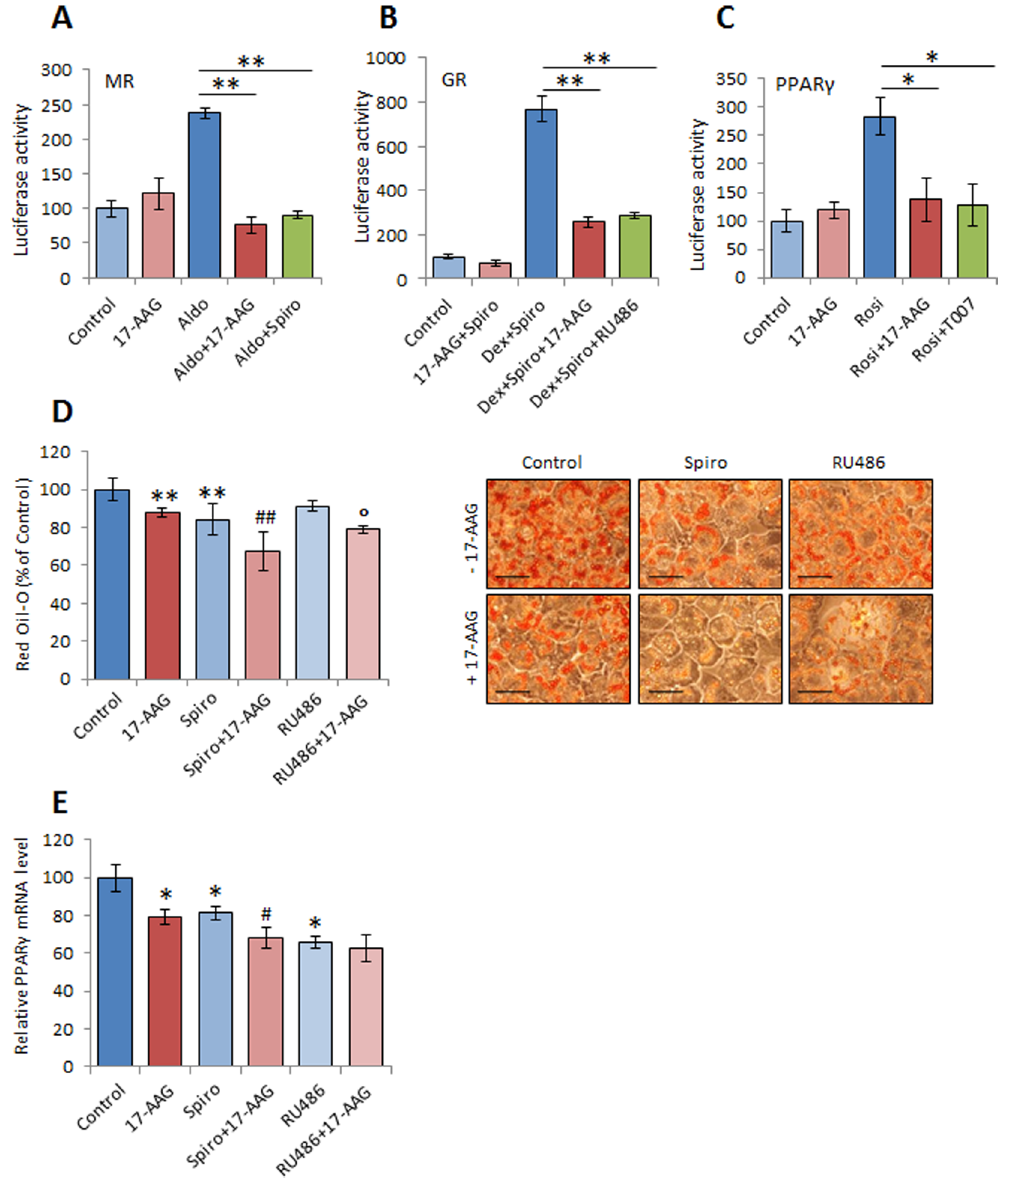
Figure 5. Hsp90 blockers inhibitMR, GR and PPAR c transcriptional activity in adipocytes. (A to C) Mature 3T3-L1 cells were co-transfected by Metafectene with the reporter genes MMTV-luc (for A and B), PRE-luc (for C), and the constitutive luciferase vector coding for Renilla. After 30 h, cells were exposed to the indicated treatment: 17-AAG (100 nM), aldosterone (100 nM), spironolactone (1 m M), dexamethasone (100 nM), RU486 (1 m M), Rosiglitazone (1 m M), T0070907 (3 m M) for 16 h. After hormone treatment, cells were washed with PBS and lysed with 200 m l of passive lysis buffer (Promega). Luciferase activity was determined by using a luciferase kit (Promega). Luciferase activity was normalized for constitutive Renilla luciferase. Values are given as mean 6 SD (n=3), *p , 0.05, **p , 0.01. (D and E) 3T3-L1 preadipocytes were induced to differentiate in absence or presence of spironolactone (10 2 6 M) or RU486 (10 2 6 M) alone or in combination with 17-AAG (100 nM) only for the first 3 days of differentiation protocol. (D) Red oil staining (scale bar, 70 m m) and analysis of triglyceride content.(E) PPAR c mRNA levels in 3T3-L1 preadipocytes after the first 3 days of differentiation.*p , 0.05, **p , 0.01 vs Control, # p , 0.05, ## p , 0.01 vs Spiro, u p , 0.05 vs RU486.